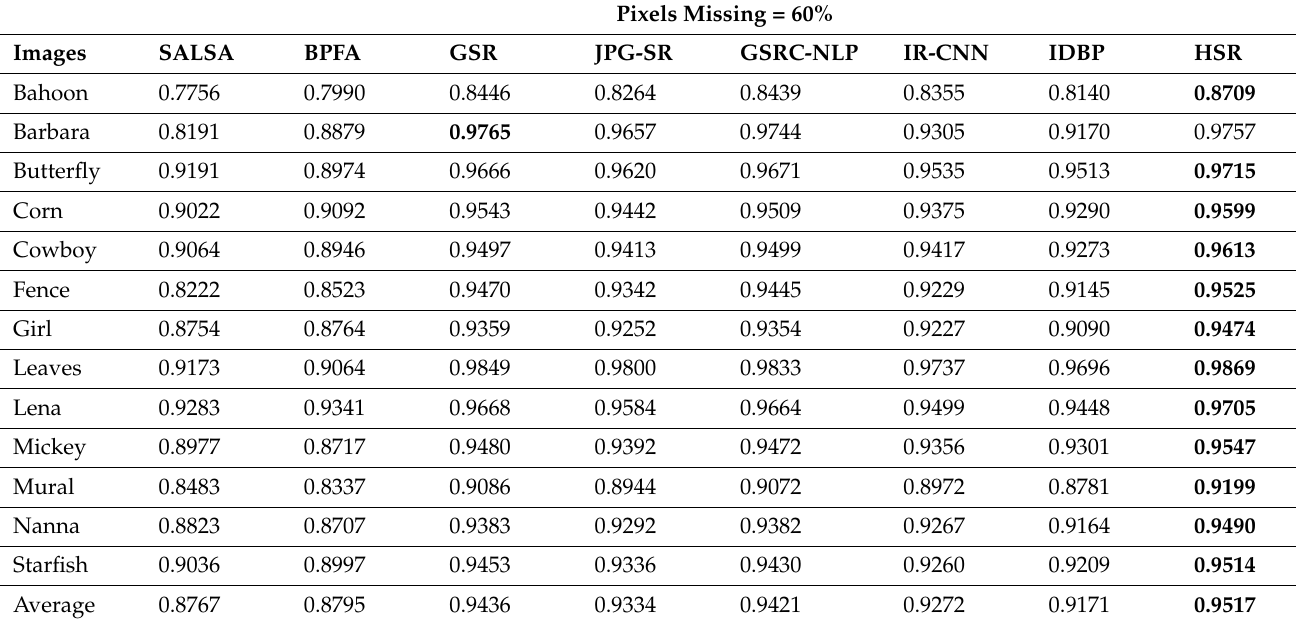
Table 7. SSIM values of our proposed HSR model and other comparison models after image restora- tion with pixels missing rate 60%.